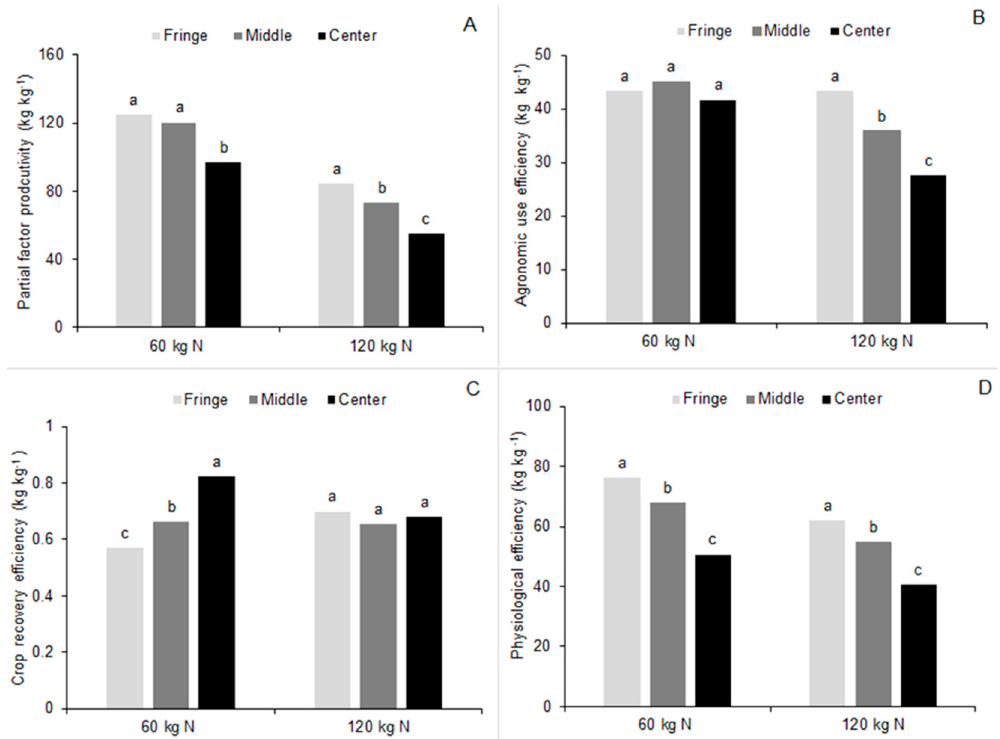
Figure 6. Use efficiencies of applied mineral fertilizer N averaged over years and differentiated by hydrological position: ( A ) partial factor productivity (kg grain yield kg − 1 N applied), ( B ) agronomic N use efficiency (kg grain increase kg − 1 N applied), ( C ) crop recovery efficiency (kg N increase kg − 1 N applied) and ( D ) physiological N use efficiency (kg grain increase kg − 1 N uptake). Different letters indicate significant differences by Tukey test at p ≤ 0.05 between positions.